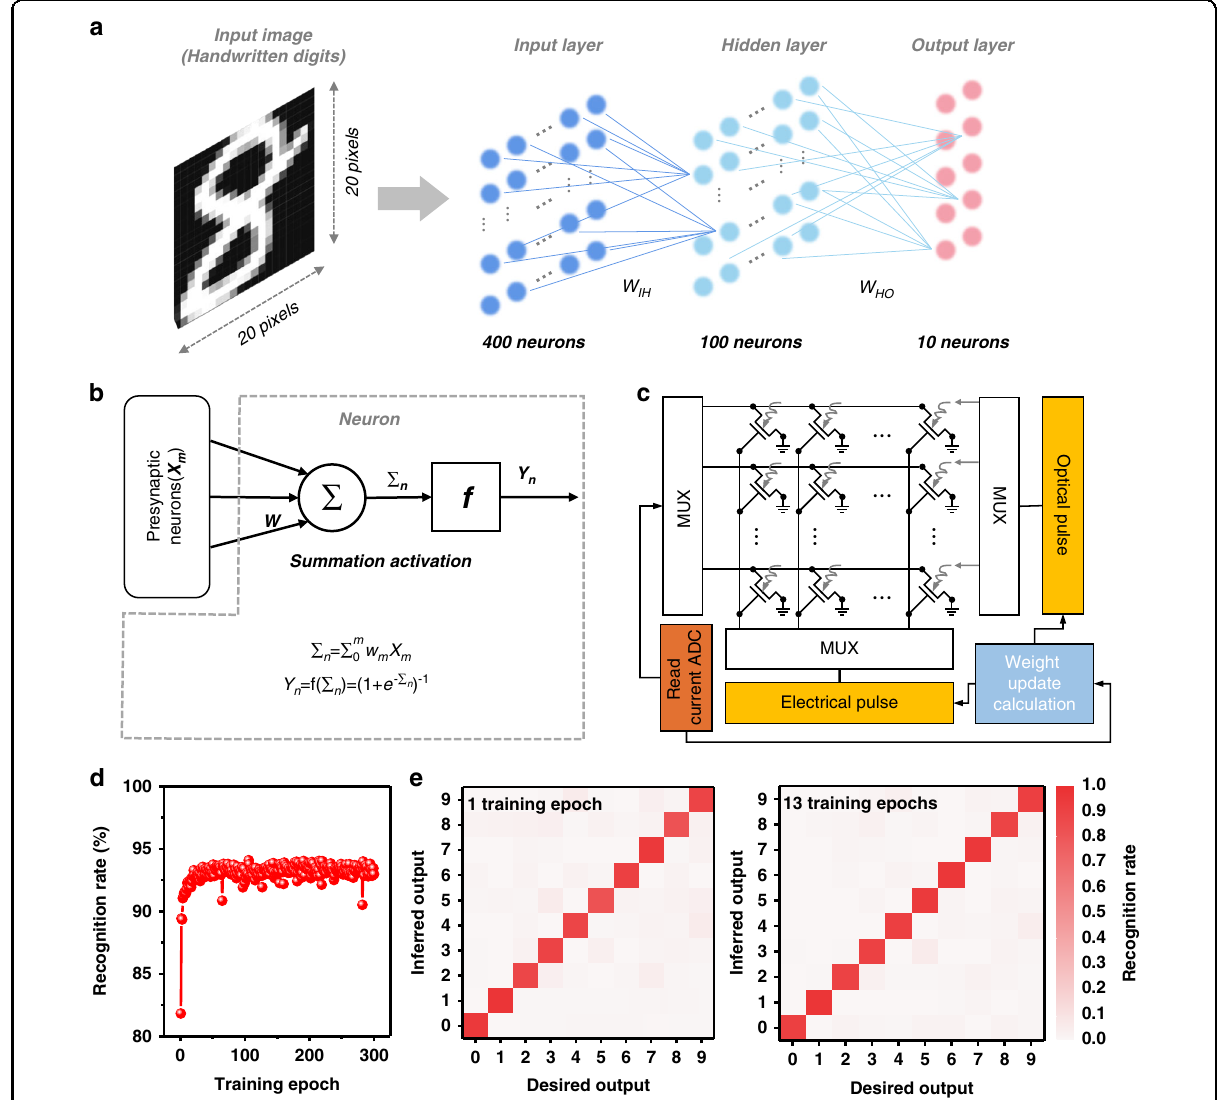
Fig. 4 Simulation of FONN for image recognition by the arti fi cial photonic synapse. a Schematic illustration of the simulated FONN with a three-layer architecture. b Schematic of a neuron node and synaptic weight update process. c Circuit block diagram for the simulation showing the photonic synapse array and the peripheral circuits. MUX, multiplexer; ADC, analog-to-digital converter. d Calculated MNIST recognition rate as a function of training epochs. e The confusion matrix between desired value and predicted value after 1 and 13 training